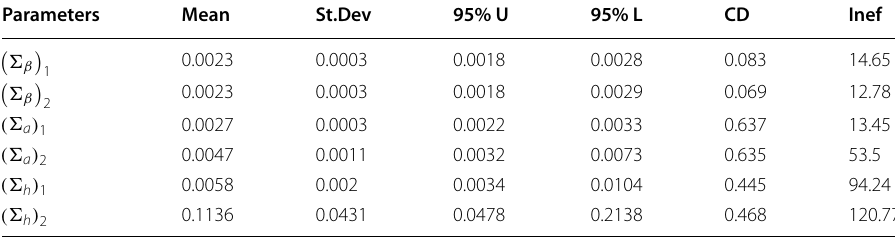
Table 2 Estimation results of the TVP-VAR-SV parameters with the ordering { EPU , NEF , R } Parameters Mean St.Dev 95% U 95% L Inef